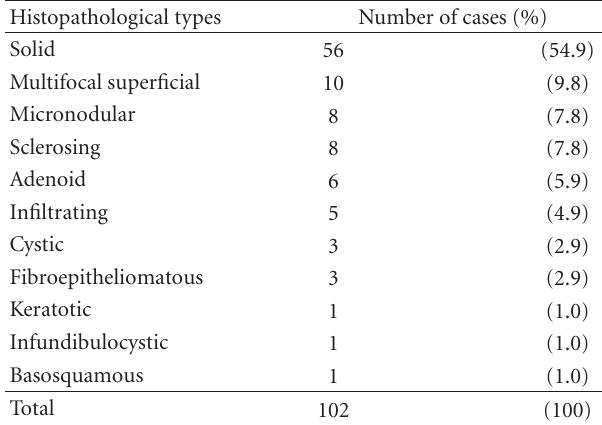
Table 1: Histopathological types of BCC cases at Sapporo Medical University between April 2005 and March